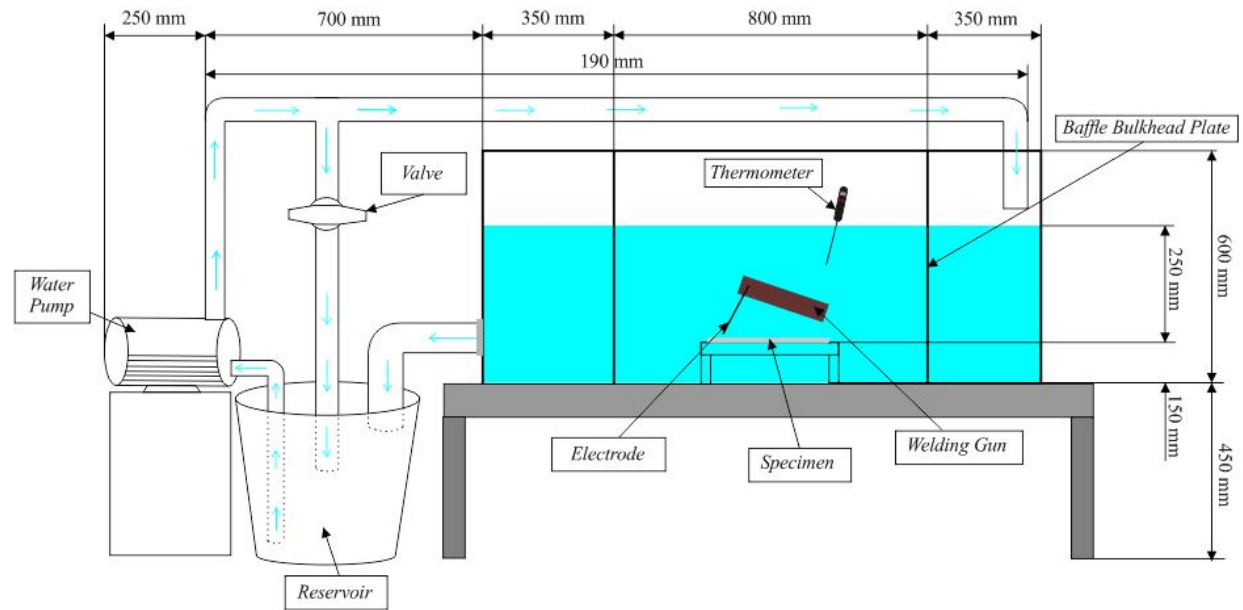
Figure 1. The experimental platform of the water flow control system.